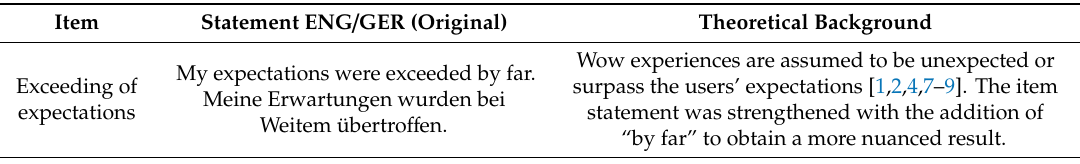
Table 4. Items used in the online